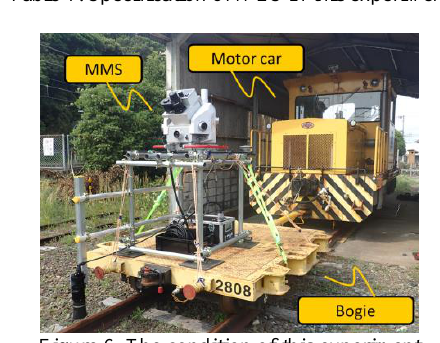
Table 1. Specification of MLS in this experiment